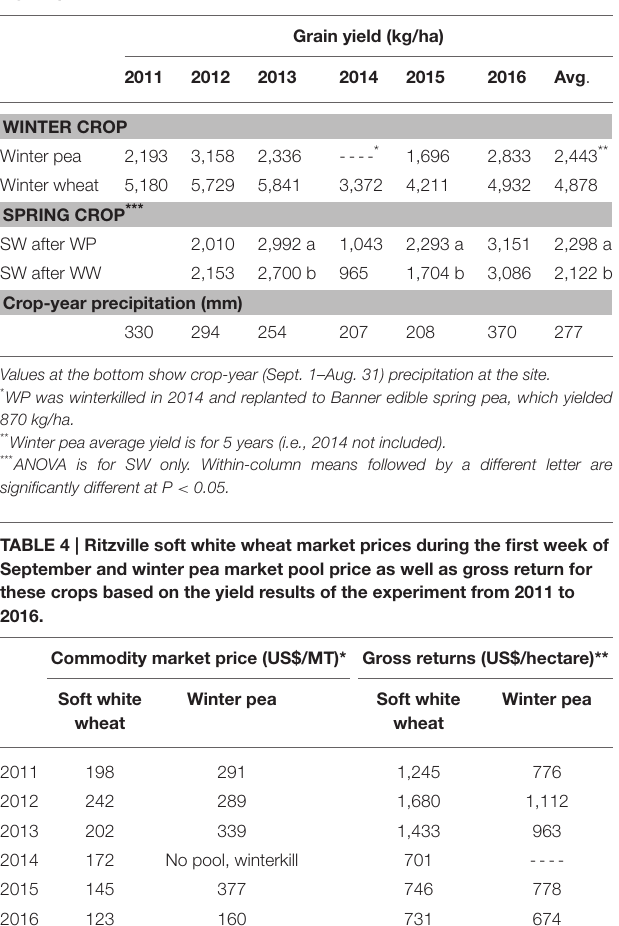
TABLE 3 | Yield of winter pea (WP) and winter wheat (WW) as well as the subsequent yield of spring wheat (SW) following both WP and WW over a 6-year period at Ritzville, WA.